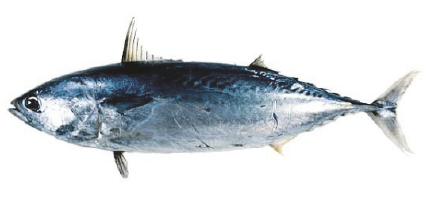
Figure 1: Lateral view of tuna fish (Euthynnus affinis)